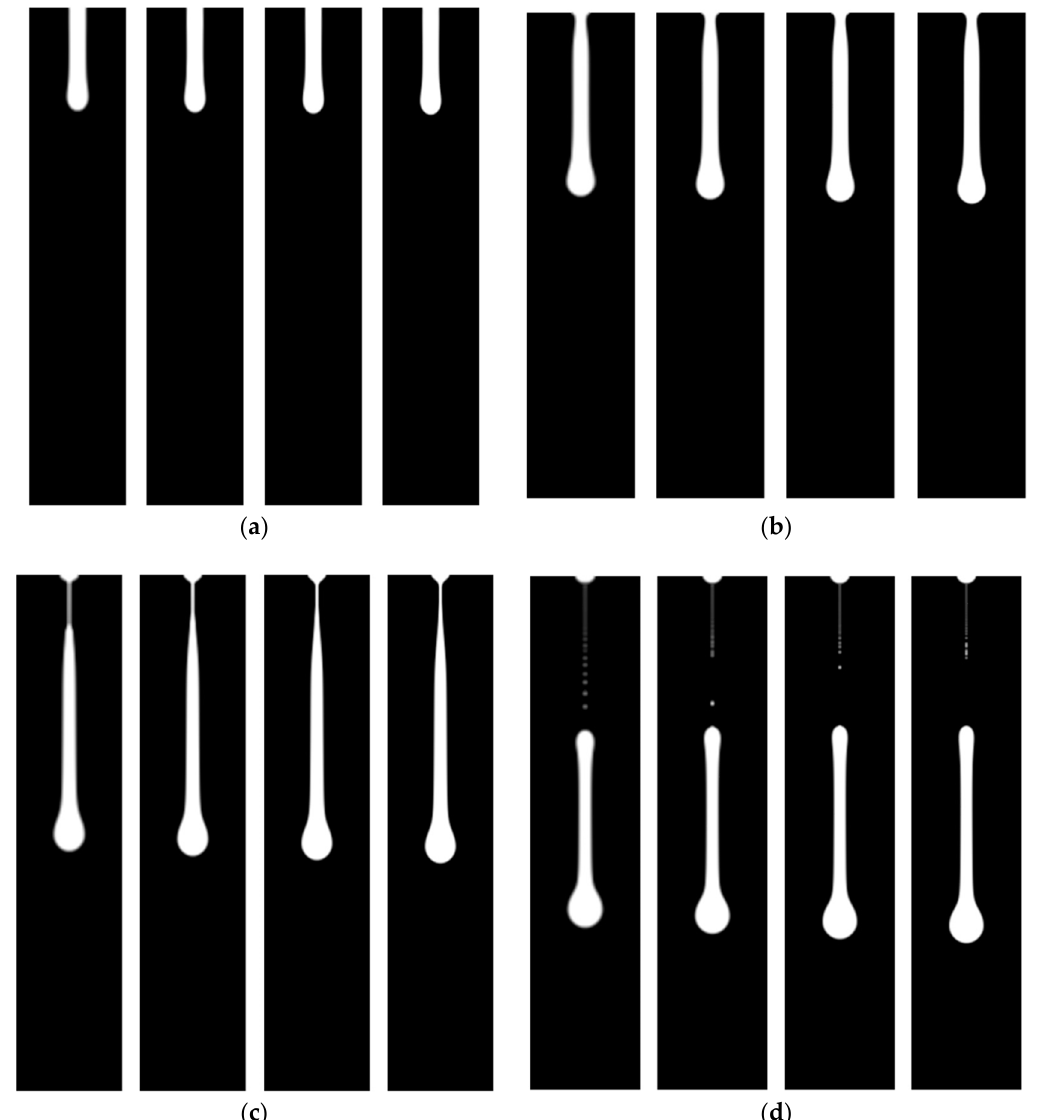
Figure 2. Ink fraction contours for mesh 1 through 4 (left to right) at the following four time steps: ( a ) 6 μ s, ( b ) 12 μ s, ( c ) 18 μ s, and ( d ) 24 μ s.